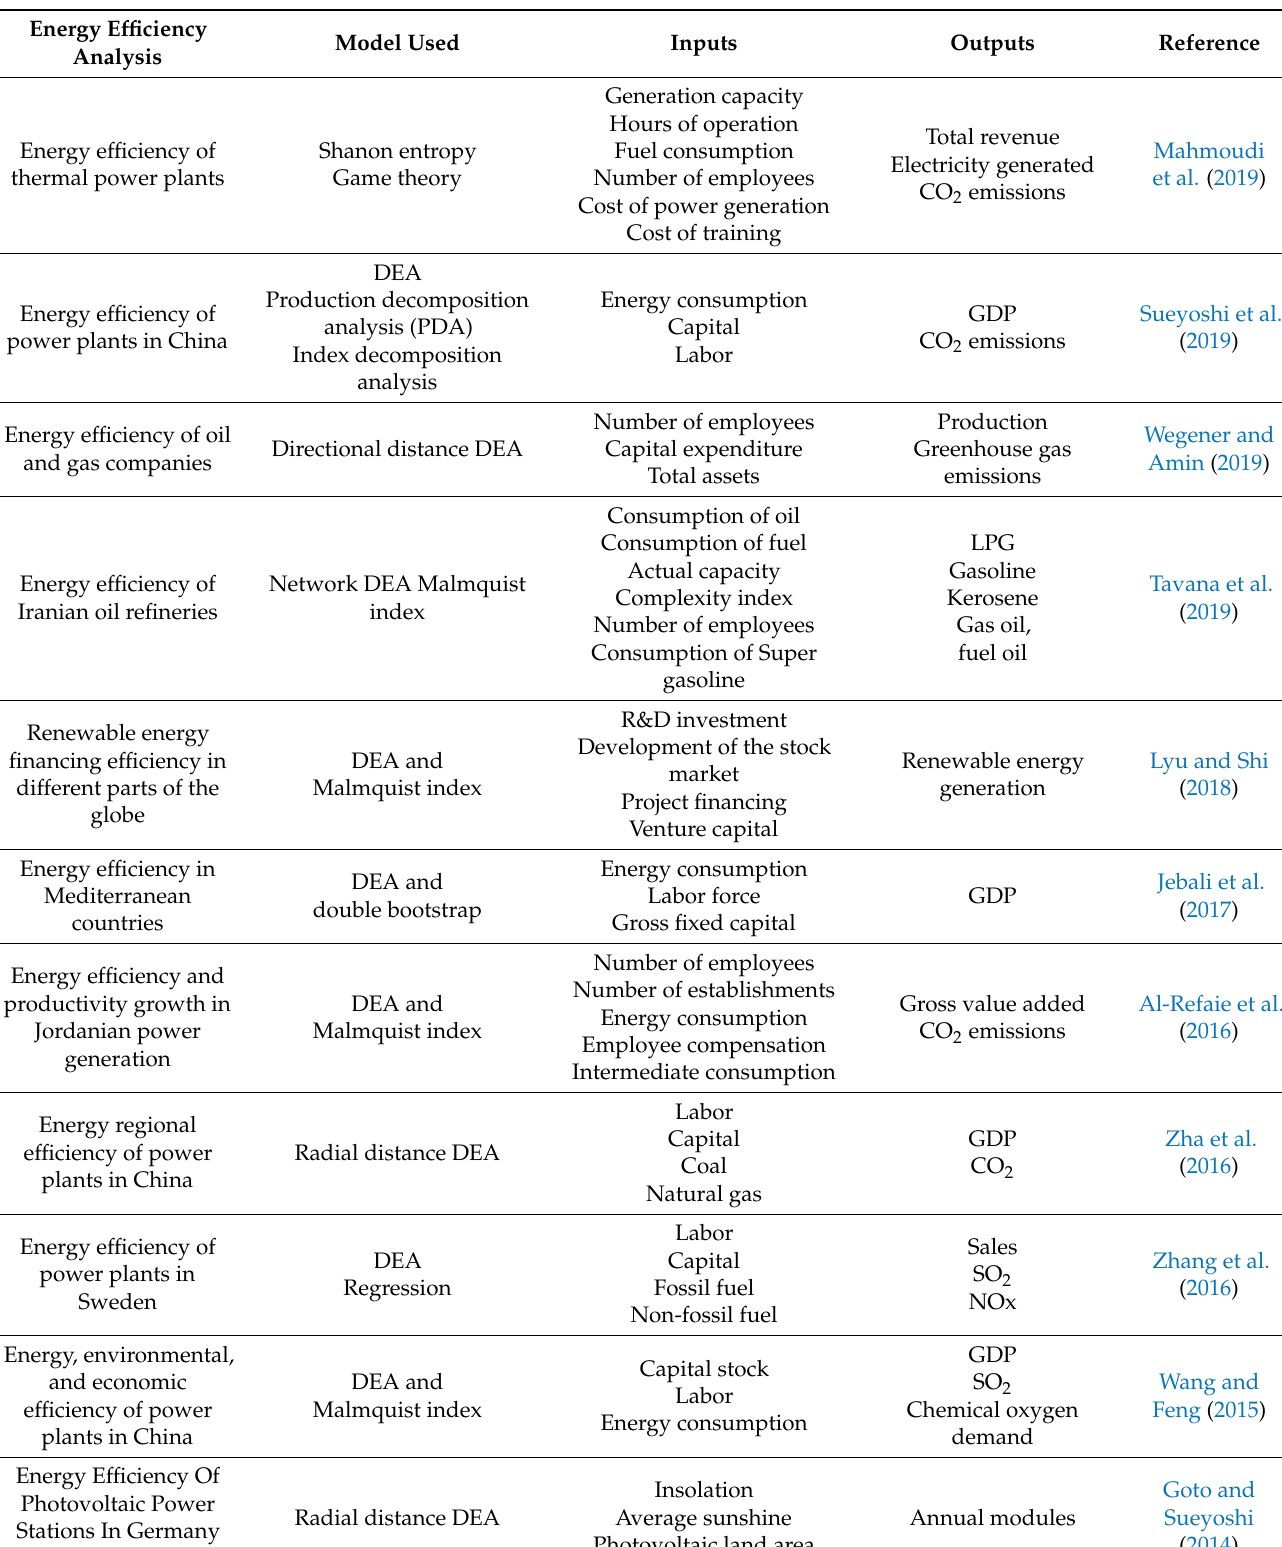
Table 1. Summary of inputs and outputs used in previous